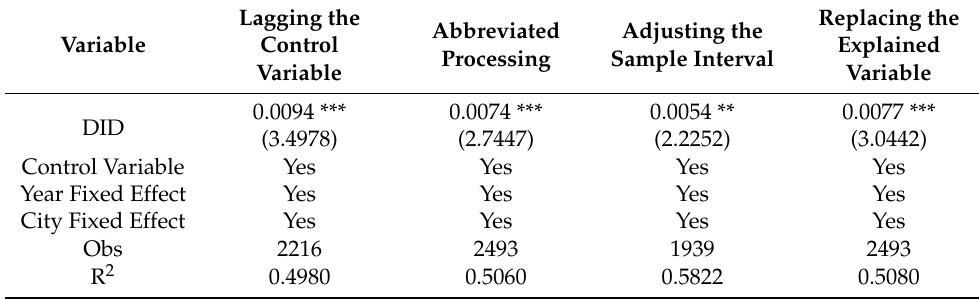
Table 3. Further robustness test